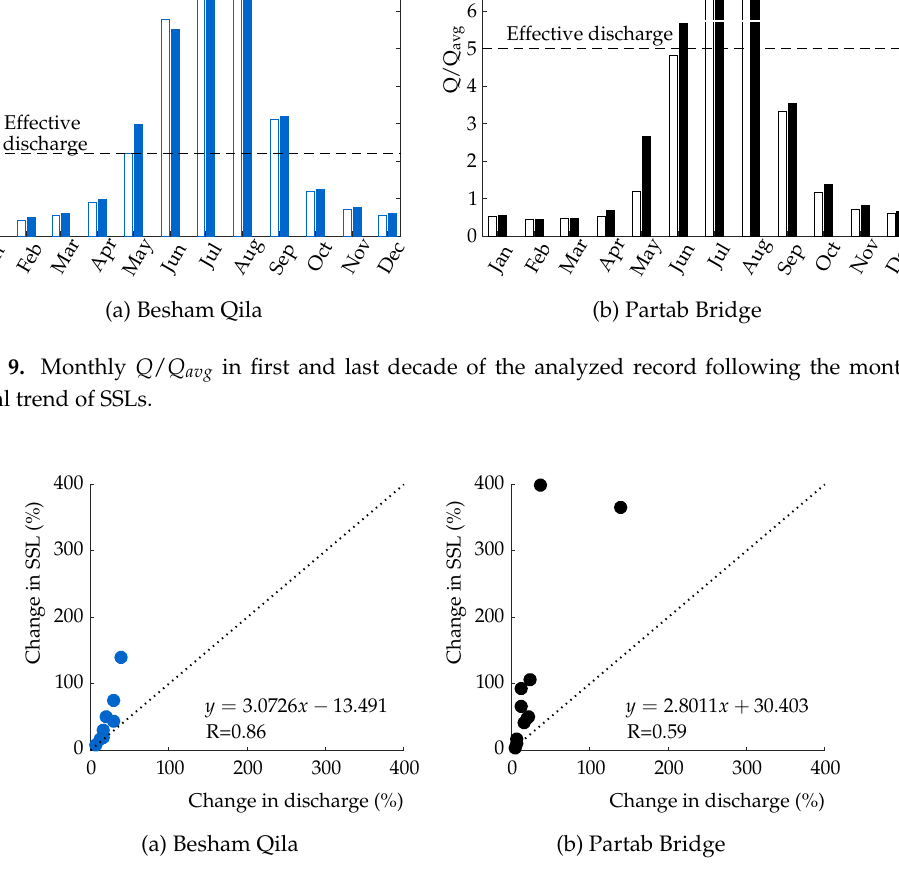
Figure 10. Linear regression of mean monthly changes in SSLs versus changes in